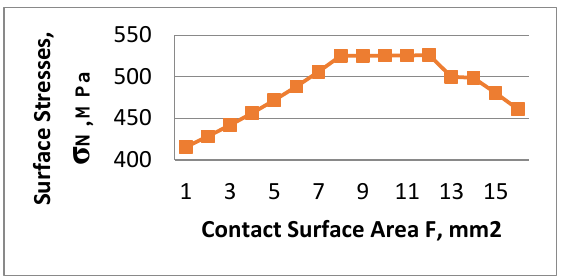
Figure 12. Dependence of the influence of changes in the wheel wear contact area on the value of normal contact stresses.